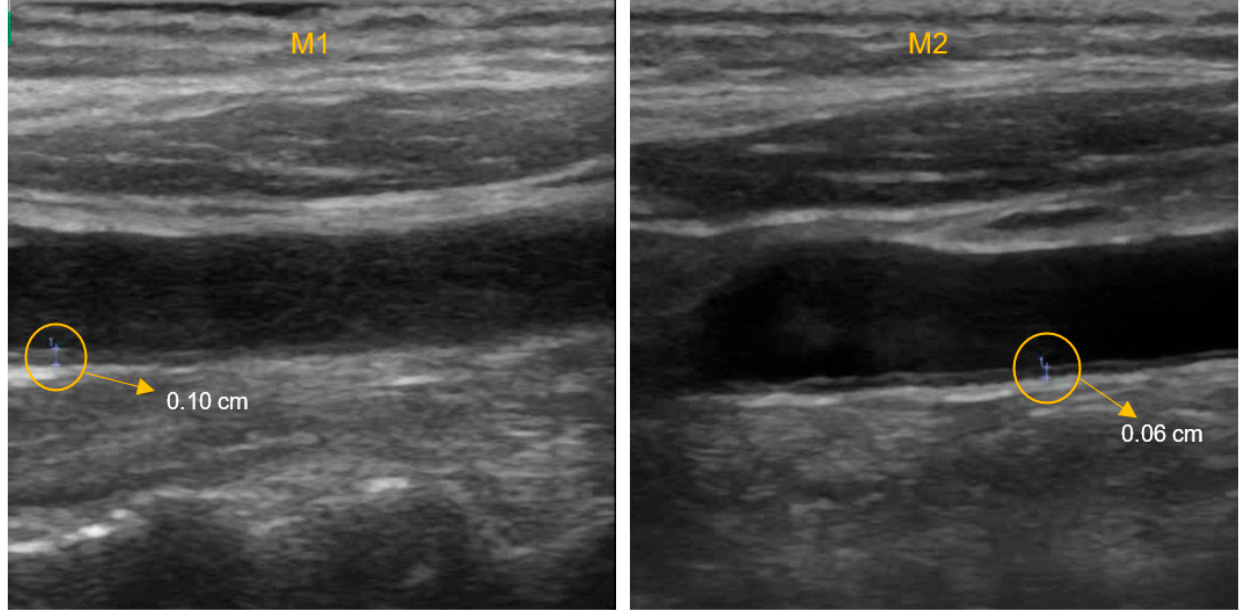
Figure 4. Images of the carotid artery of a study participant at different times of assessment: before the intervention (M1), the participant had an intima and media thickness of the carotid artery (IMT) of 0.10 cm; after the intervention (M2), a reduction in the IMT to 0.06 cm was verified. Table 3. Biochemical marker